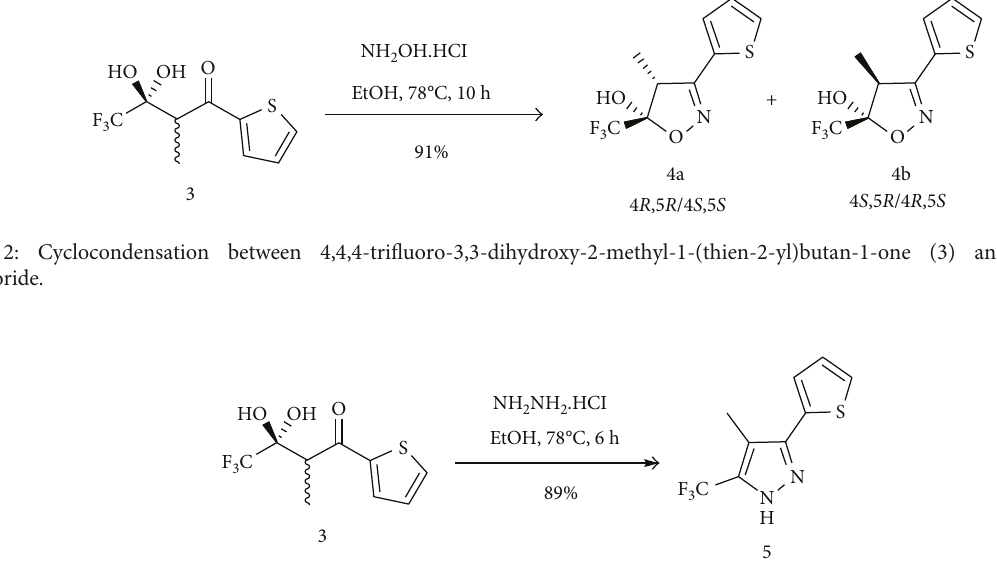
Scheme 3: Cyclocondensation between 4,4,4-tri fl uoro-3,3-dihydroxy-2-methyl-1-(thien-2-yl)butan-1-one (3) and hydrazine hydrochloride. Table 3: Crystallographic data and structure re fi nement parameters of